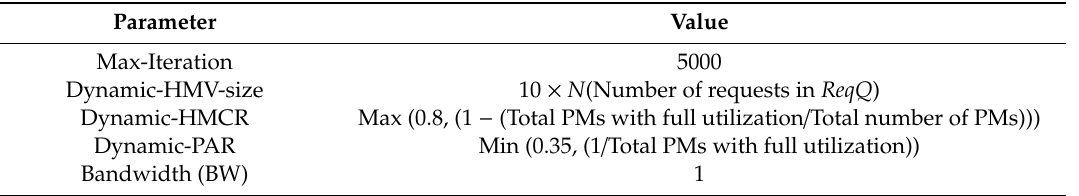
Table 1. Adaptive harmony search algorithm dynamic parameter